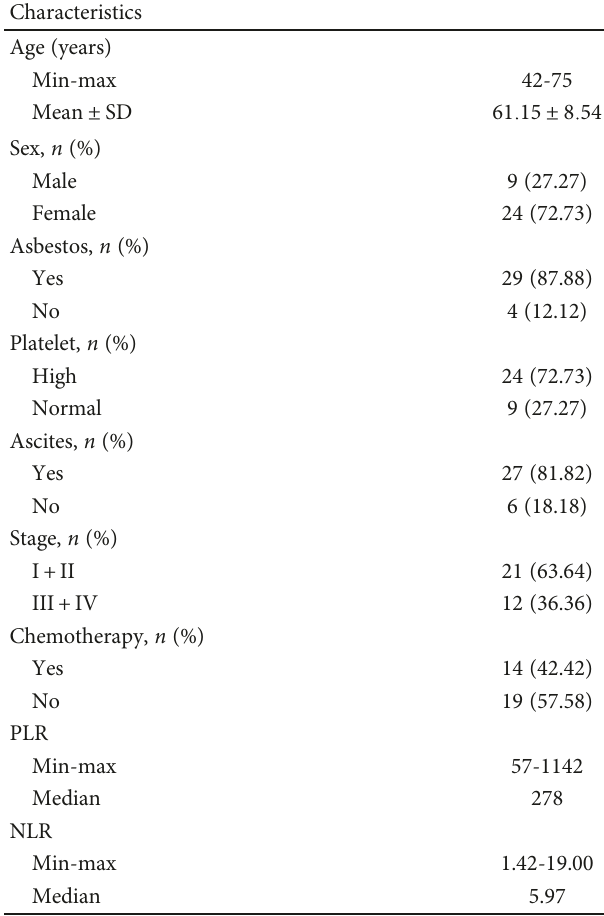
Table 1: Distribution of descriptive